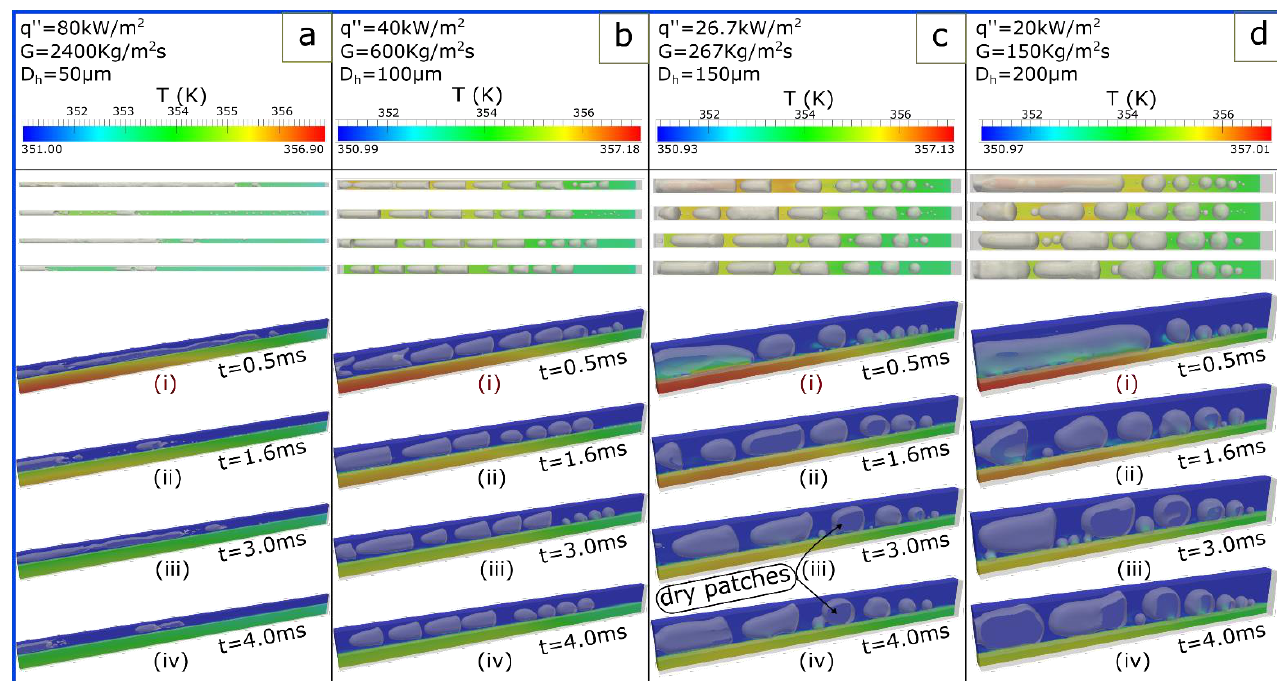
· V = 9.1611 × 10 − 9 m 3 /s. Four common